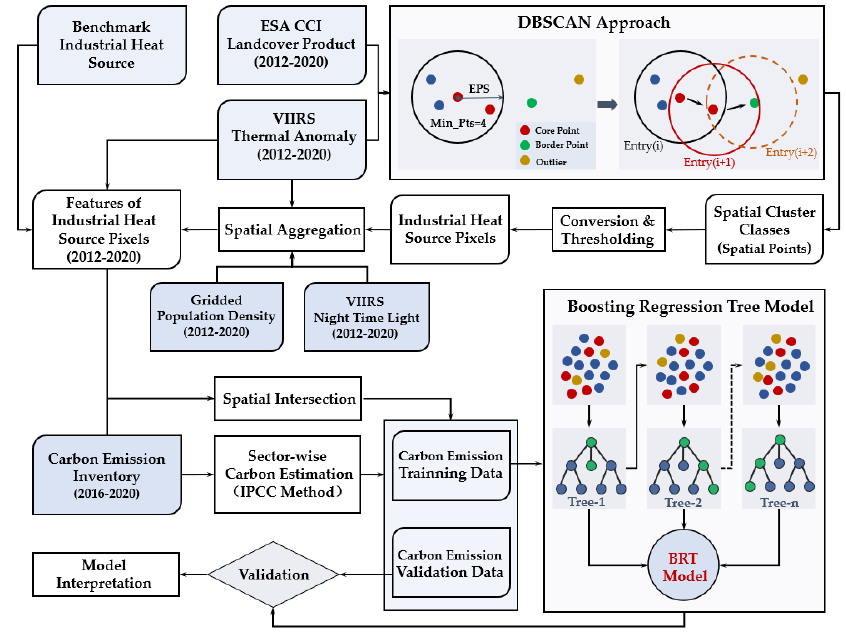
Figure 4. Flowchart of the data processing and modeling methodology utilized in this study.